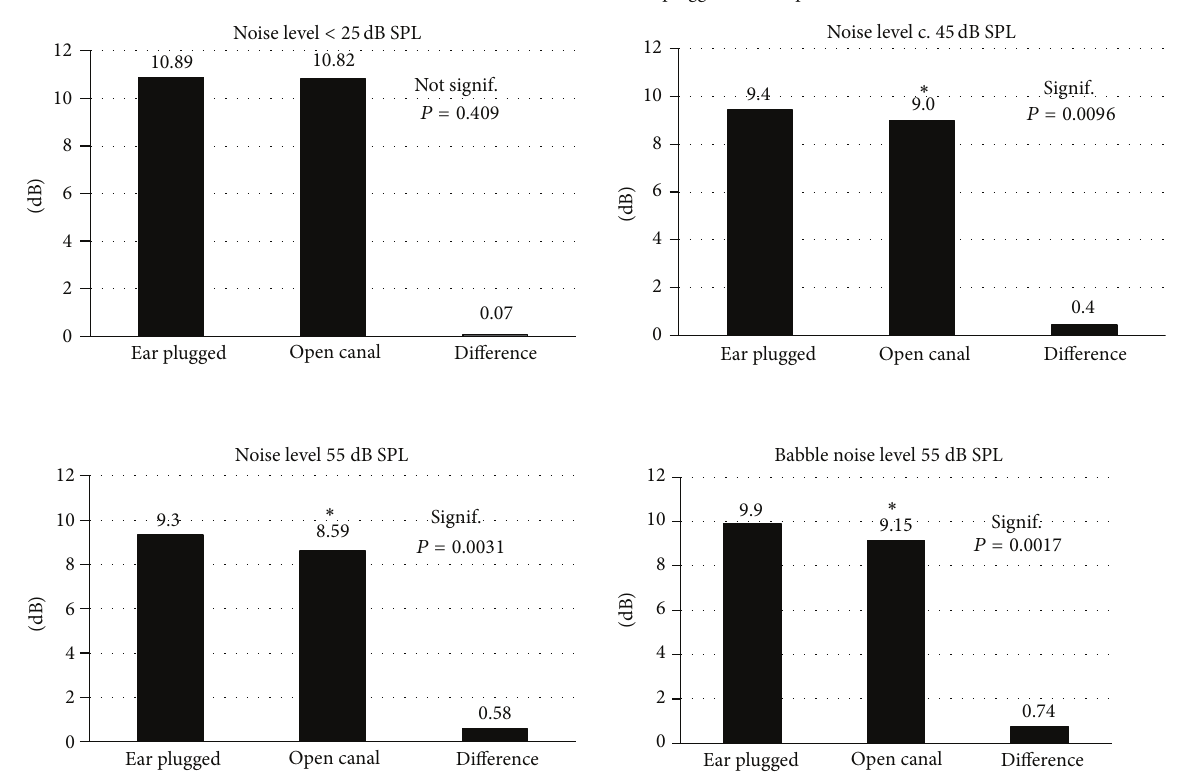
Figure 2: Plots of average DPOAE levels and the difference recoded with contralateral ear occluded or open ( 𝑁 = 6 subjects). Significance of the difference (paired Student’s 𝑡 -test) is